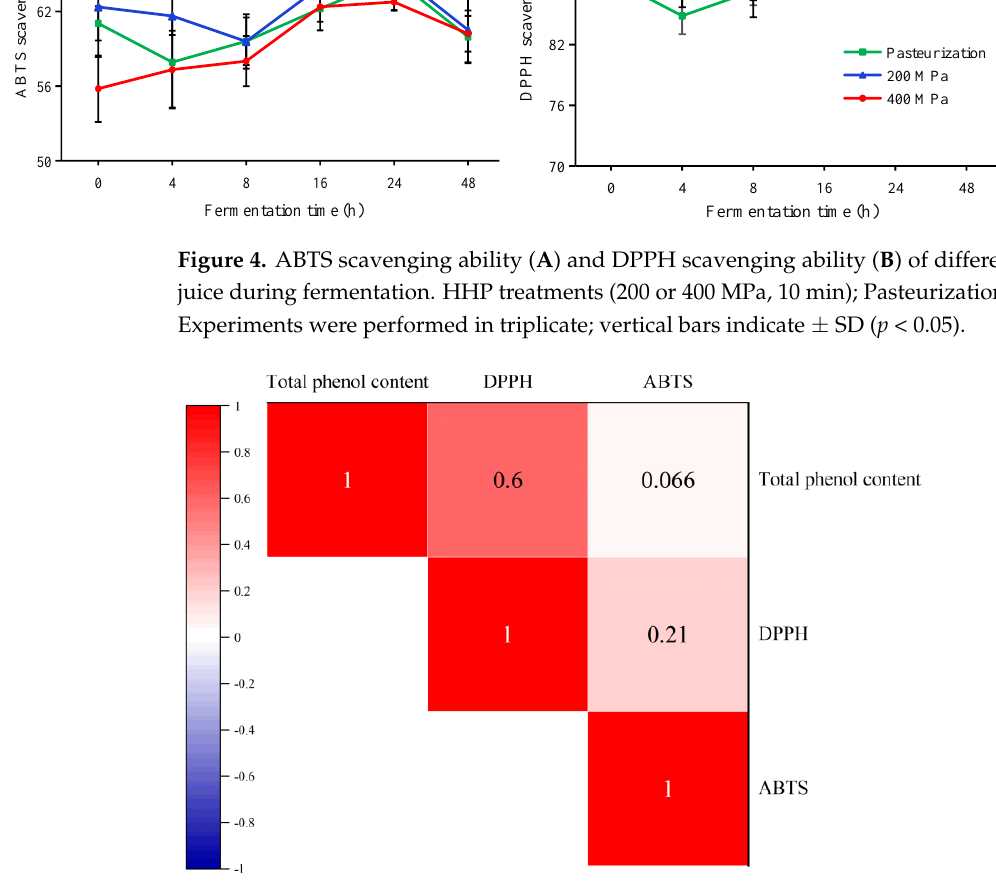
Figure 4. ABTS scavenging ability ( A ) and DPPH scavenging ability ( B ) of different treated apple juice during fermentation. HHP treatments (200 or 400 MPa, 10 min); Pasteurization (85 °C, 15 min).